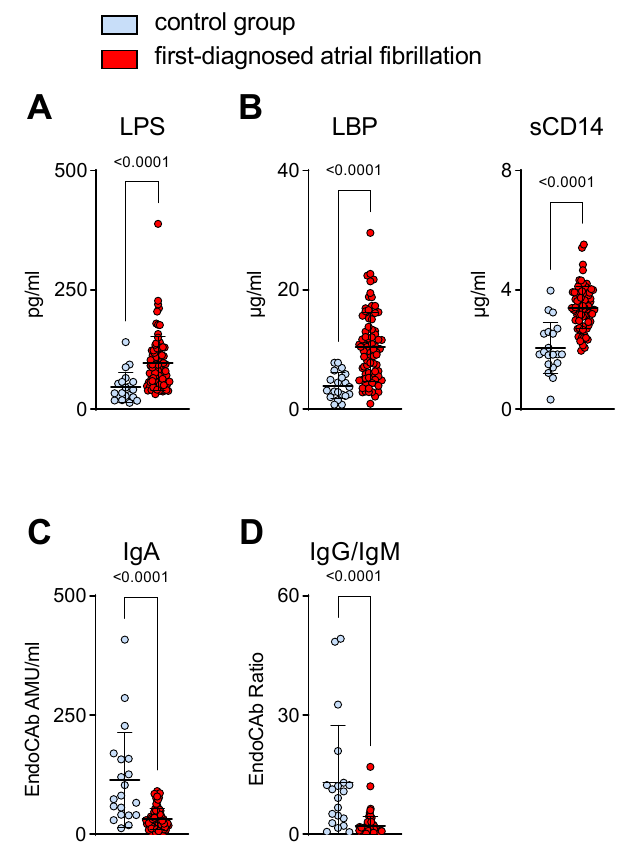
Figure 2. Biomarkers suggest the elevation of circulating gut-derived endotoxin in patients with first-diagnosed AF. Concentrations of markers for increased microbial translocation in plasma were measured by ELISA. Elevated levels of direct (lipopolysaccharide, LPS) ( A ) and indirect (LPS-binding protein, LBP; soluble CD14, sCD14) ( B ) indicators of low-grade endotoxaemia were present in plasma during early AF. Lower titres of circulating endotoxin core IgA antibodies (EndoCAb) ( C ) and a reduced ratio of EndoCAb IgG/IgM titres ( D ) in the AF cohort compared to controls. Results are expressed as single values ( n = 20/80), mean ± SD, and p